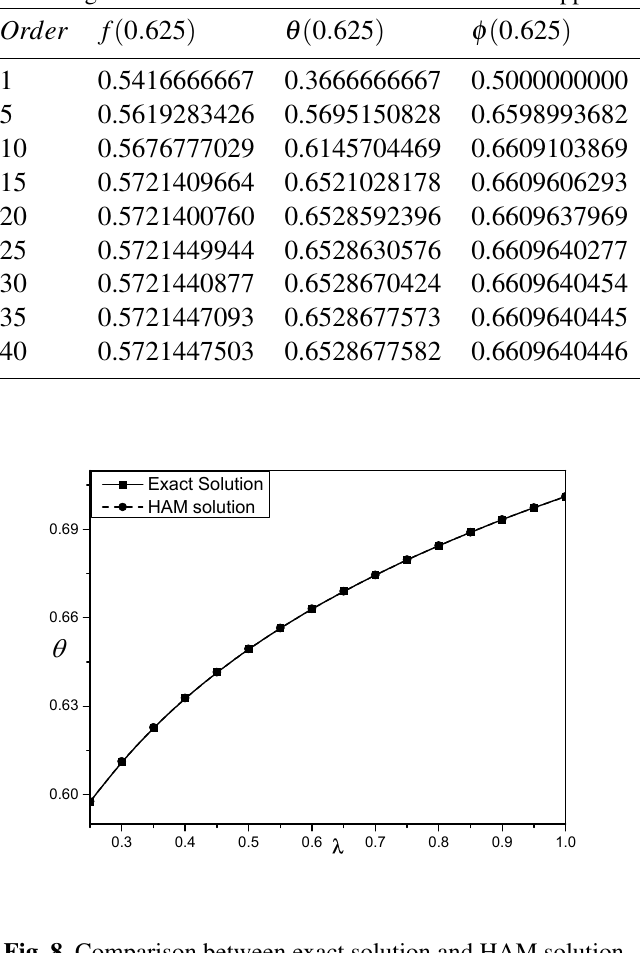
Fig. 8 Comparison between exact solution and HAM